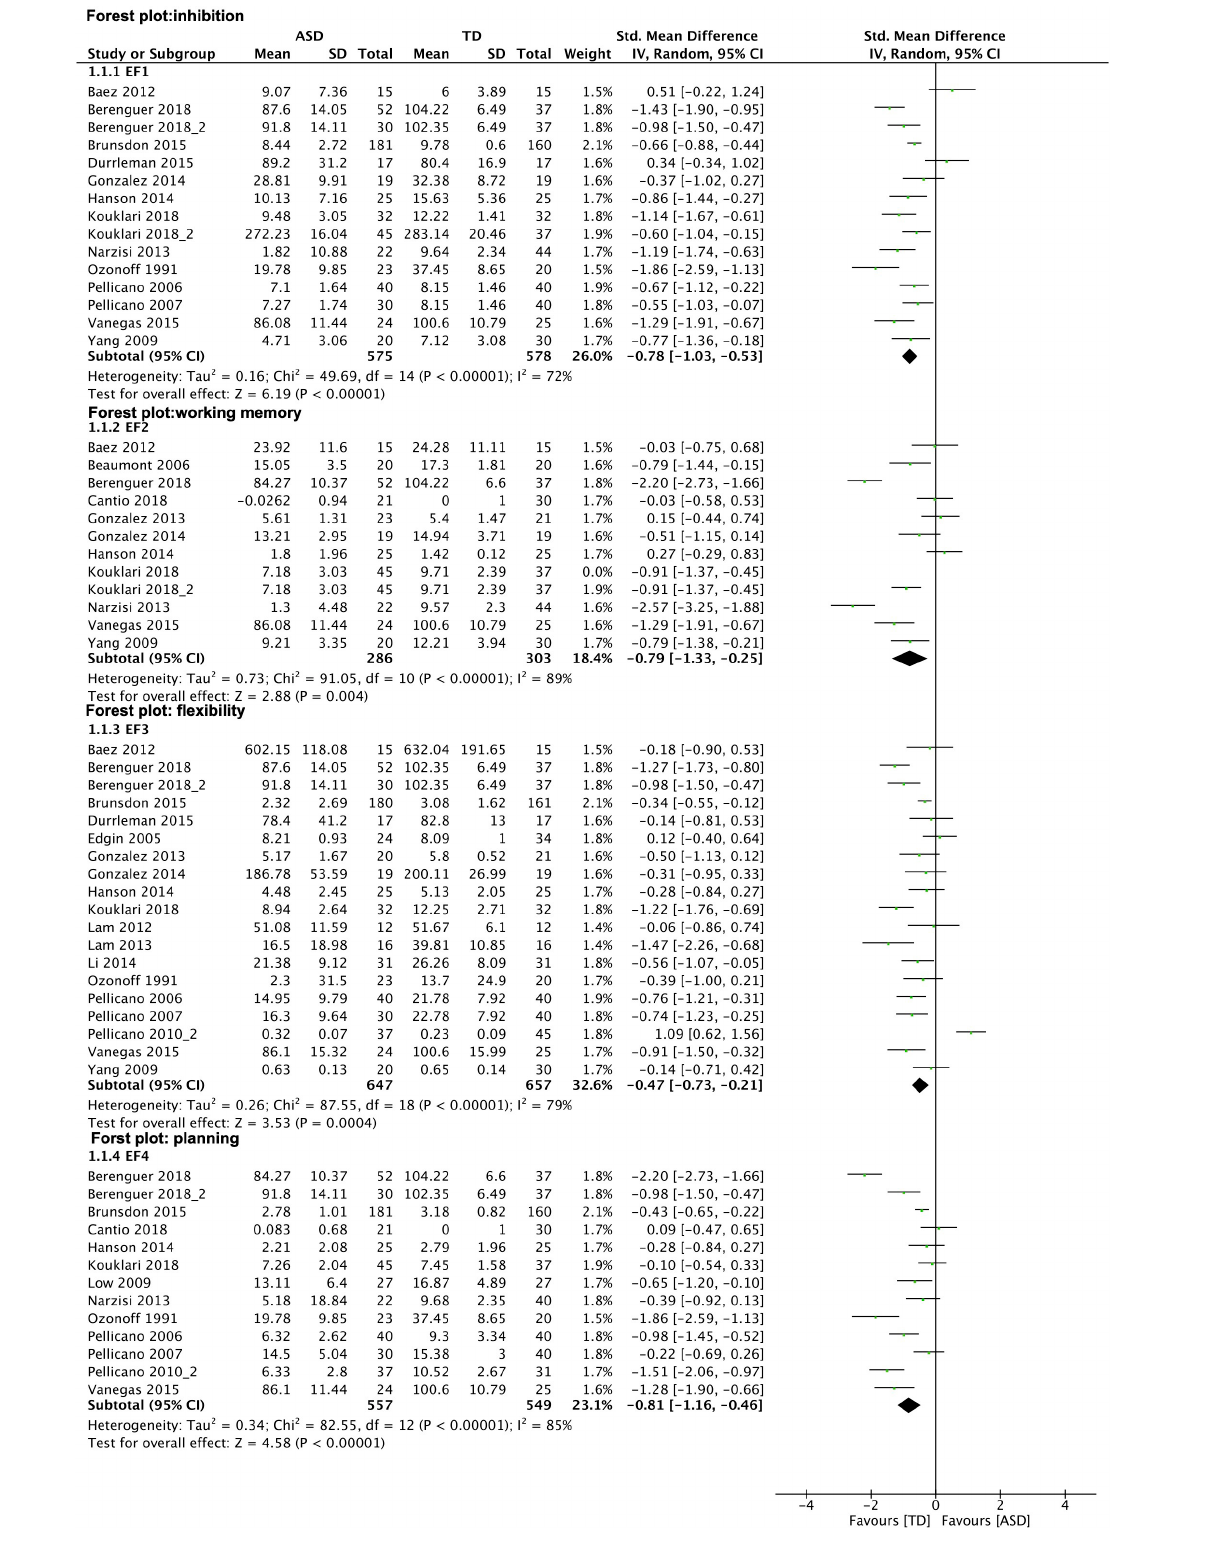
FIGURE 5 | Forest plot–executive function: subgroup analysis of EF domains. Results show medium effect size measures for all EF subtypes observed. Graphical explanations: horizontal lines present 95% confidence Interval of the effect sizes for each study; green dot: hedges‘g; diamond shape: overall effect size.